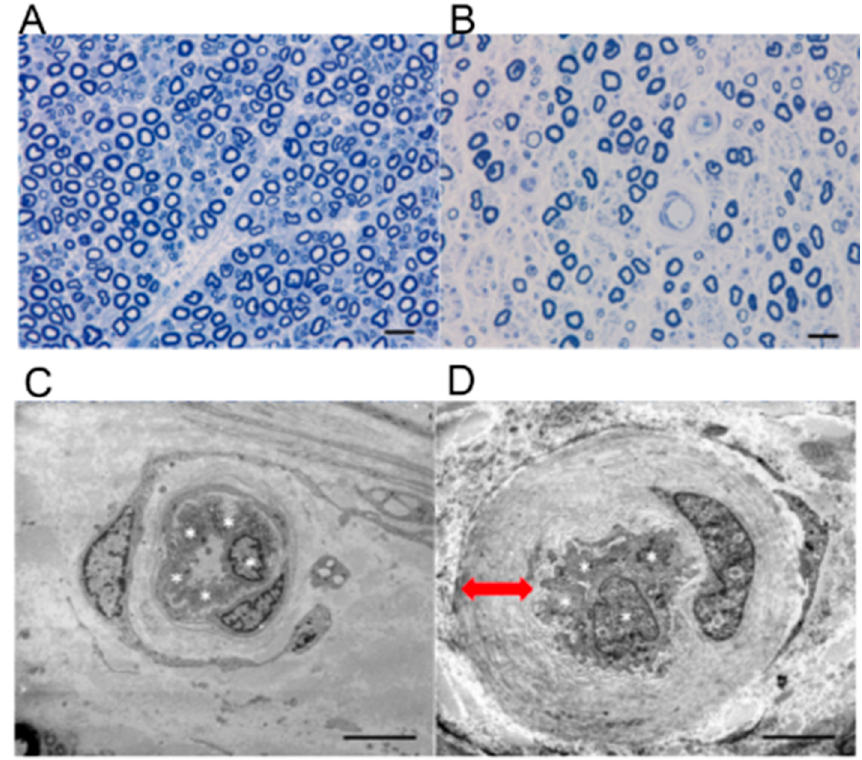
Figure 5. Pathological findings of diabetic peripheral neuropathy. Upper row: Images of sural nerve biopsy specimens from a patient with diabetic peripheral neuropathy and a healthy individual (Epon-embedded specimens; toluidine blue staining); ( A ) healthy case, 55 year old male; ( B ) diabetic peripheral neuropathy case, 60 year old male. Compared with the specimen from the healthy individual, the specimen from patient with diabetic peripheral neuropathy shows more extensive loss of myelinated nerve fibers in the endoneurium. Generally, residual myelinated nerve fibers are homogeneously distributed in the same nerve fascicle. Bar = 50 μ m. Lower row: Electron micrographs of small blood vessels in the endoneurium (left, healthy case; right, diabetic peripheral neuropathy case). ( C ) The cells in the specimen from a patient with diabetic peripheral neuropathy are swollen such that they almost occlude the lumen of the vessel. ( D ) Compared with those in the specimen from the diabetic peripheral neuropathy case, in the specimen from a patient with diabetic peripheral neuropathy, the small blood vessel is composed of four vascular endothelial cells (*). Multiple basal laminae overlap and are thickened ( ↔ ). Bar = 2 μ m.